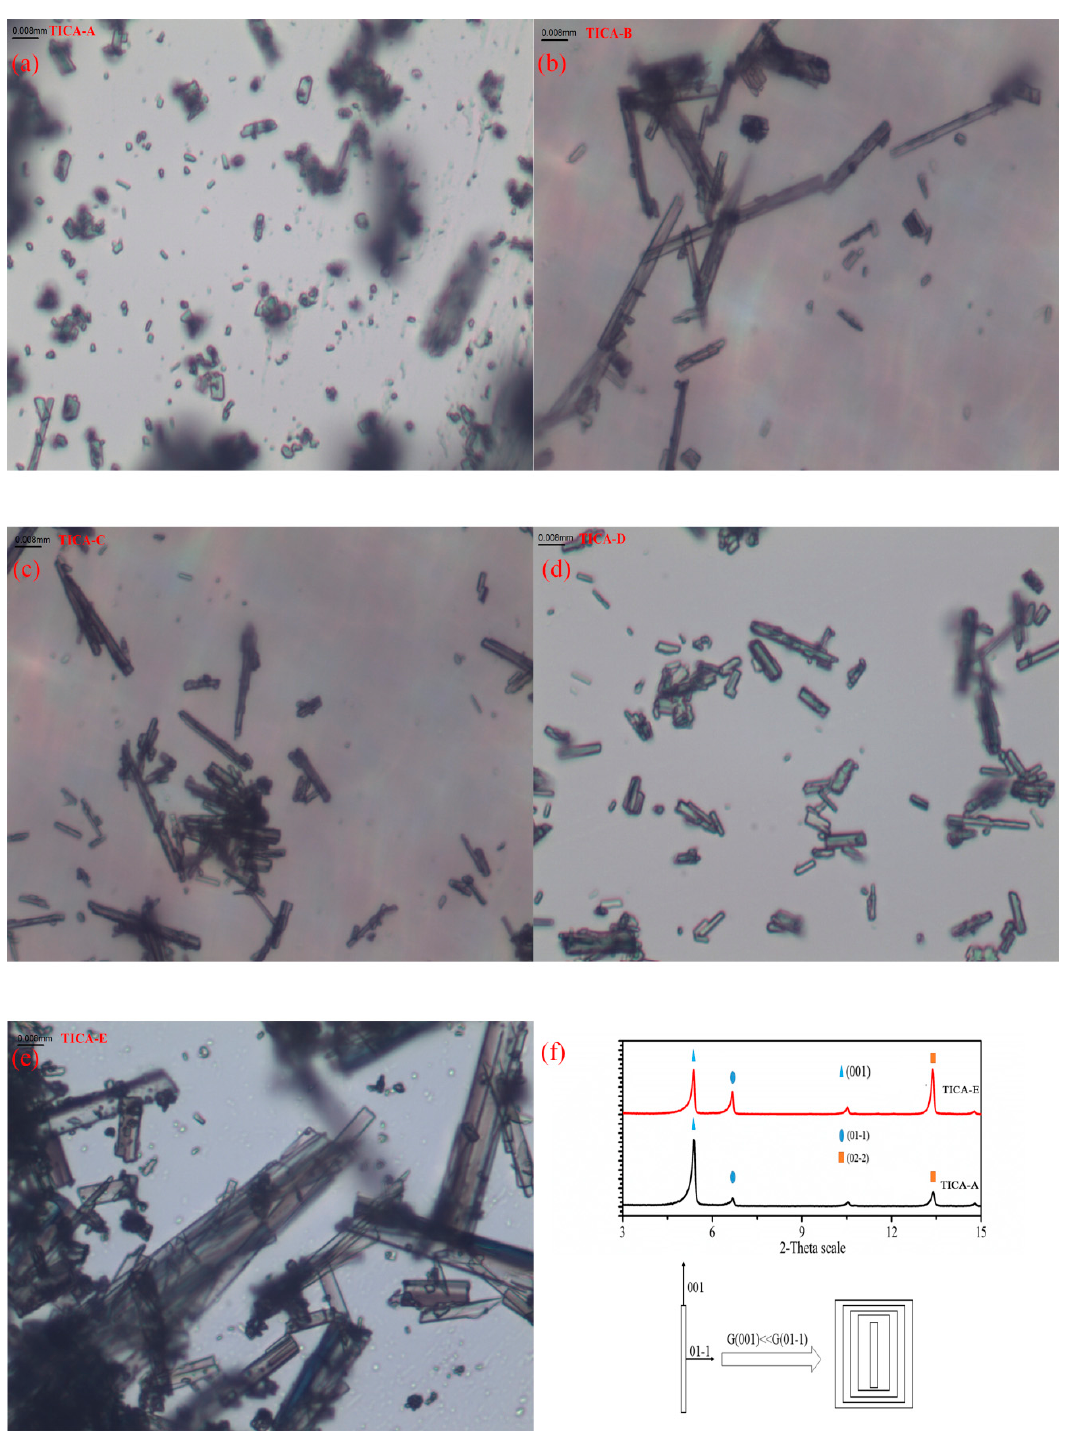
Figure 8. ( a – e ) Microscope graphs of TICA crystals and ( f ) Schematic diagram of the crystal growth of TICA crystal habits.